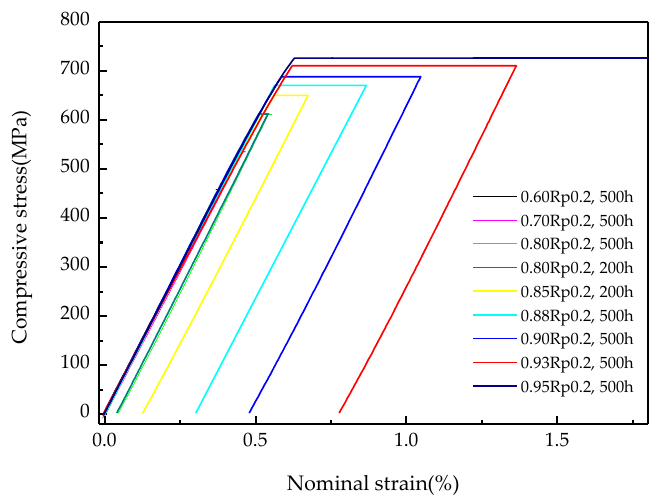
Figure 6. Stress–strain curves of TA31 titanium alloy. Figure 6. Stress – strain curves of TA31 titanium alloy. Table 3. Maximum strain and residual strain in compression of TA31 alloy